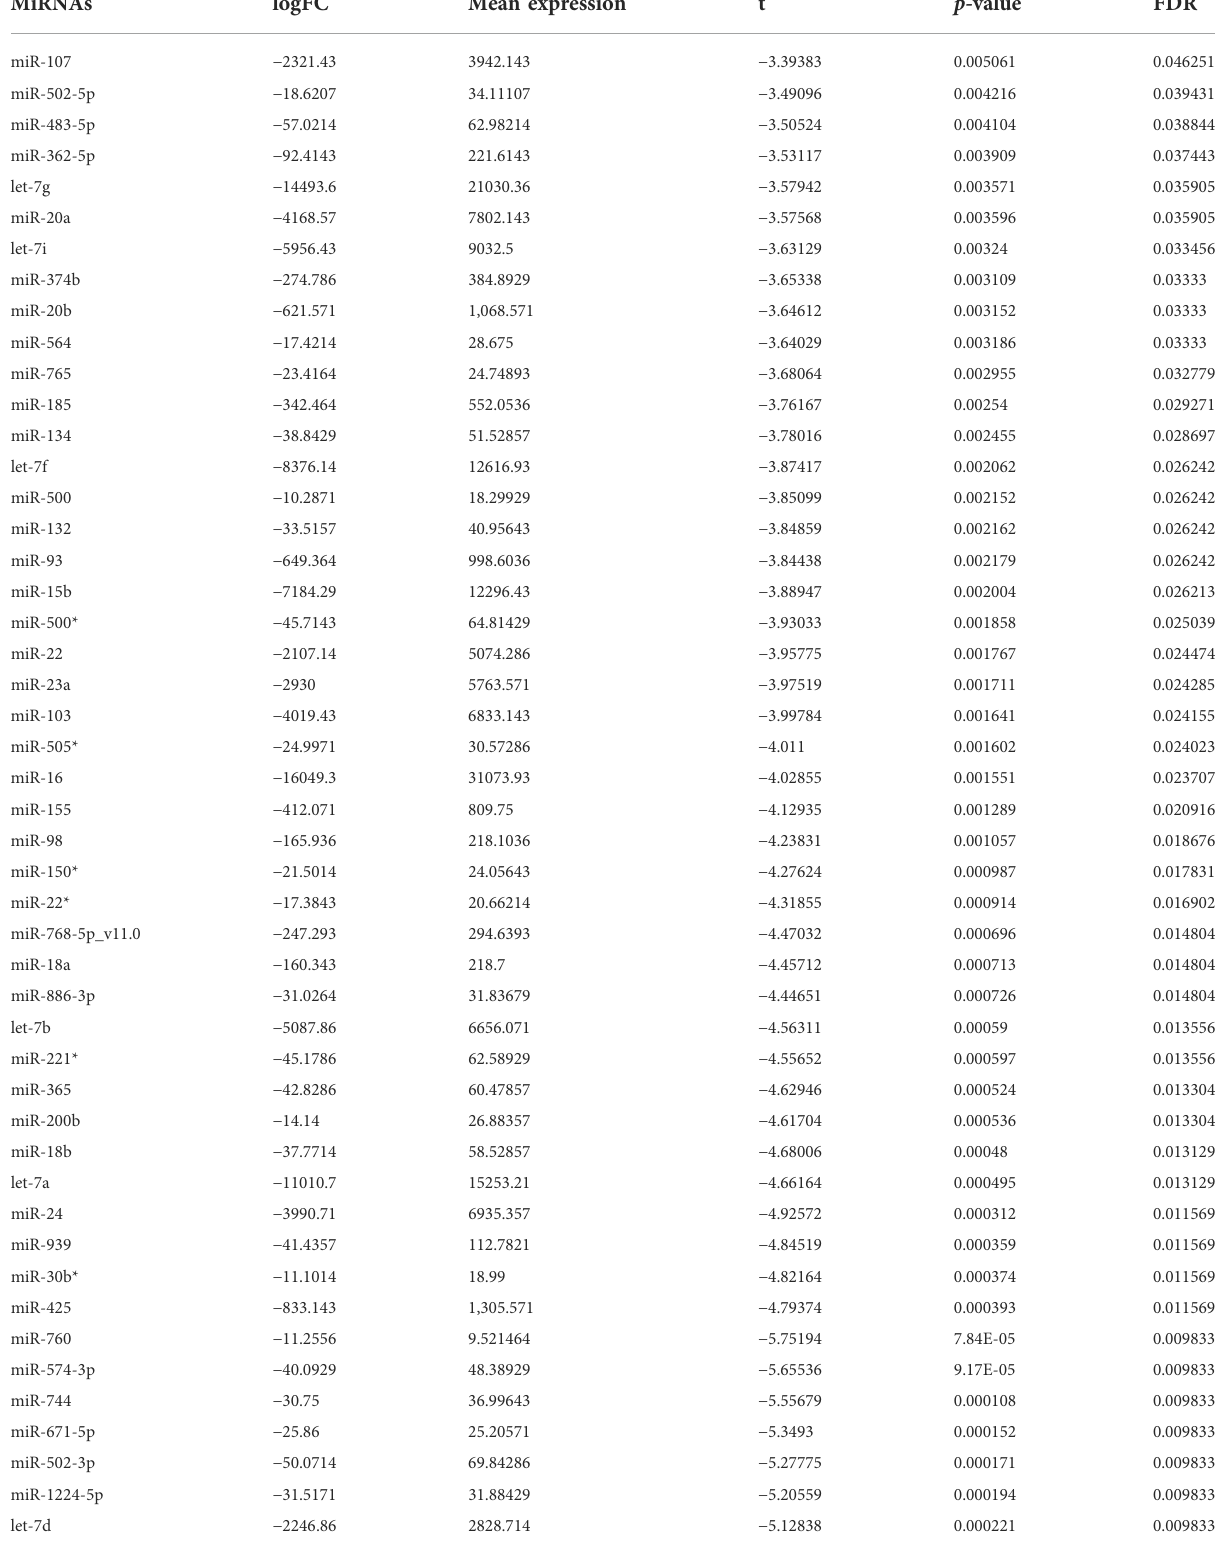
TABLE 1 The list of miRNAs with differential expression in IgA